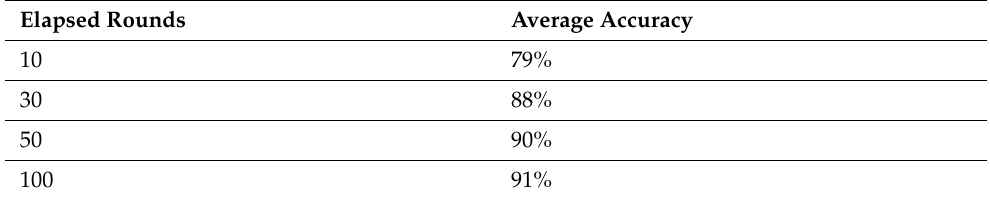
Table 2. Average accuracy results obtained with 2 devices for a uniformly distributed